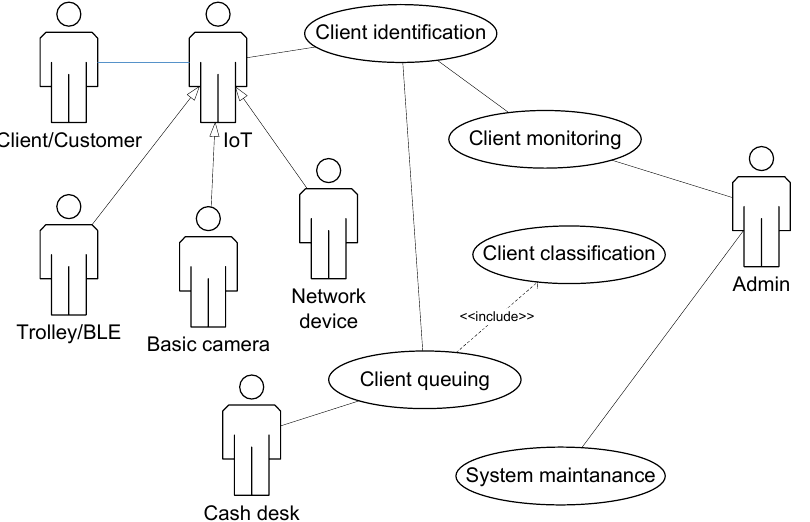
Figure 2. Intelligent queue management